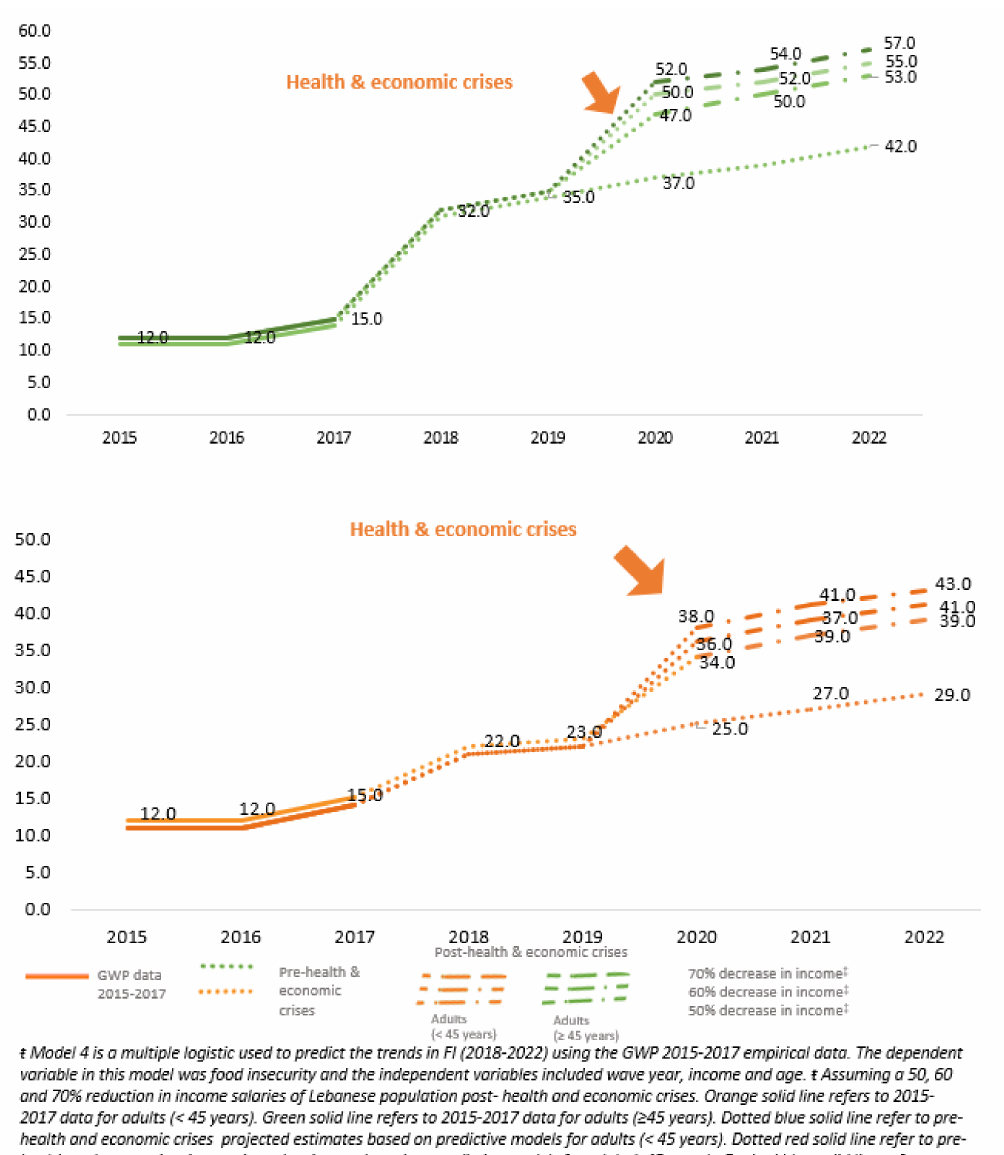
Figure 1. Trends and projections of FI (2018–2022) among Lebanese adult population using model 1 ŧ (including wave Figure 4. Projections of FI (FI) prevalence among Lebanese adult population by sex and age, using model 4